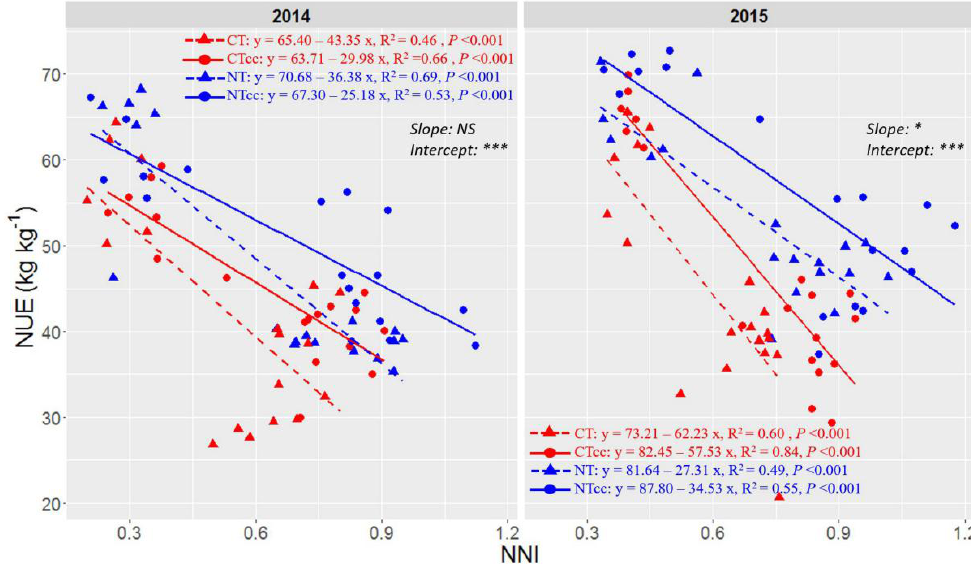
Figure 5. Nitrogen-use efficiency (NUE) of wheat as a function of N nutrition index (NNI) grown with four different tillage treatments in 2014 and 2015. NTcc: No-till with cover crops. NT: No-till without cover crops. CTcc: Conventional tillage with cover crops. CT: Conventional tillage without cover crops. Slopes and intercepts obtained with the four tillage treatments were evaluated using analysis of covariance (ANCOVA). * and *** = significant at 0.05, 0.001 probability level respectively, as indicated on the top right hand side of the figures.